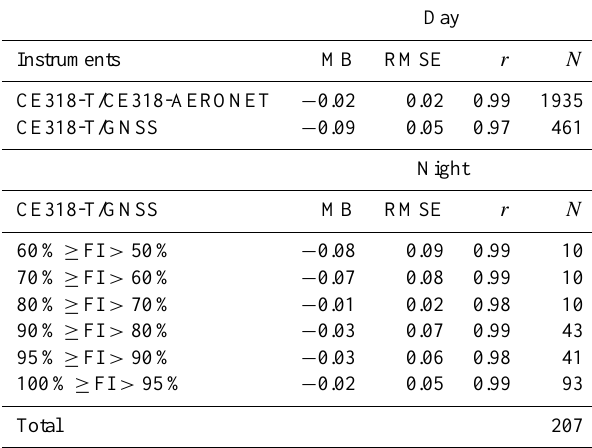
Table 8. Main statistics of the PWV comparison (in cm) extracted from CE318-T, CE318-AERONET and GNSS for daytime data, and from CE318-T and GNSS for nocturnal data. In the case of night- time information a comparison in function of the moon’s fraction of illumination (FI, in %) is also included.